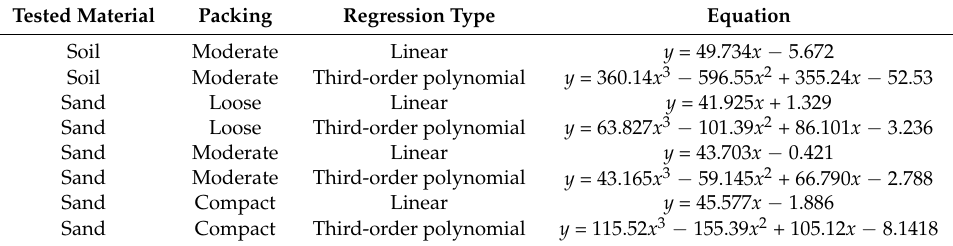
Table 4. Own linear and third-order polynomial calibration equations for ThetaProbe (direct regression